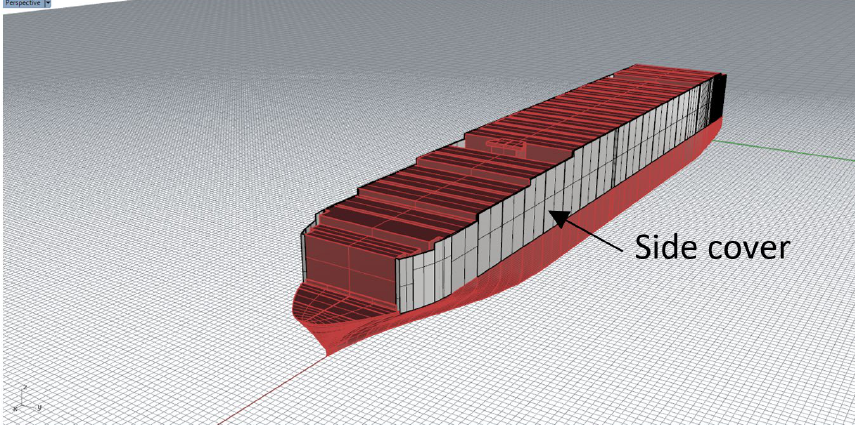
Figure 27. Ship model with side covers.